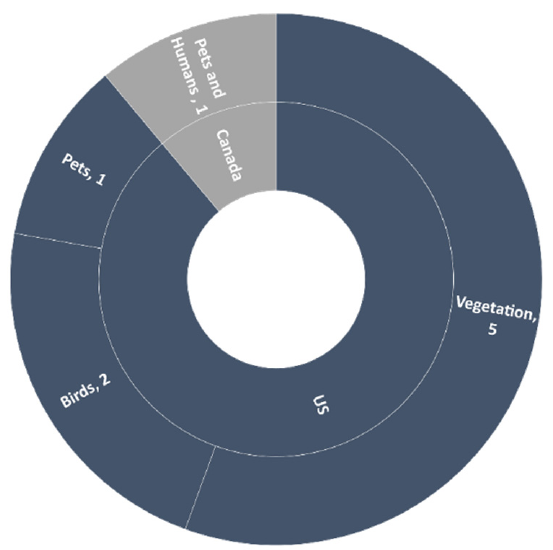
Figure 5. Number of studies on the basis of site of tick collection in North America.